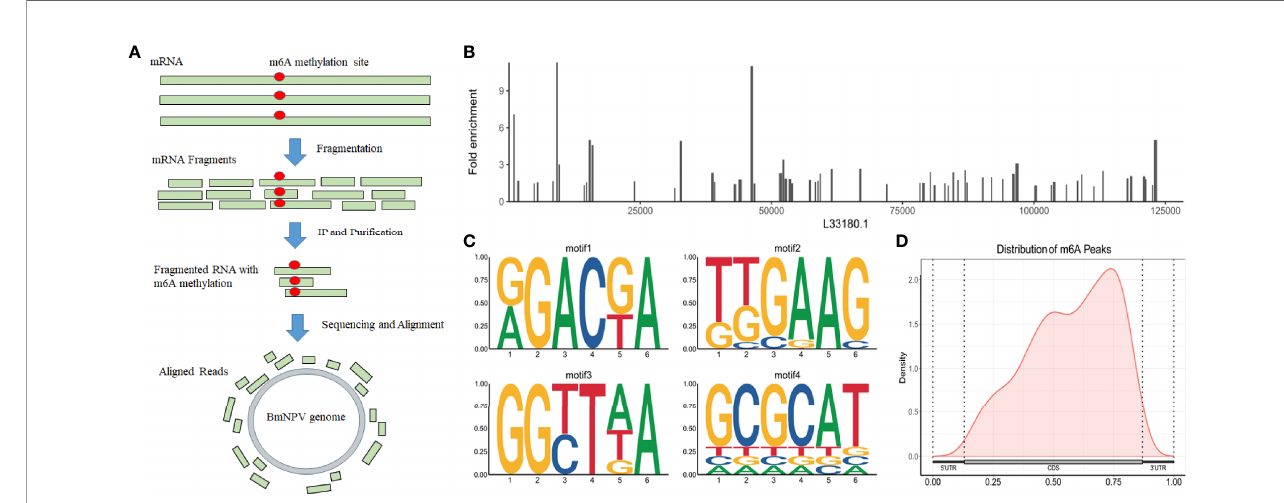
FIGURE 1 | BmNPV transcripts are m6A modi fi ed. (A) The work fl ow of MeRIP is for the detection of m6A modi fi cation in BmNPV transcripts. (B) The distribution of m6A peaks on the genome of BmNPV T3 (L33180.1). (C) The conserveness of the RRACH motifs within the identi fi ed m6A peaks using HOMER. (D) Distribution of m6A peaks on viral transcripts including 5 ′ -UTR, CDS, and 3 ′